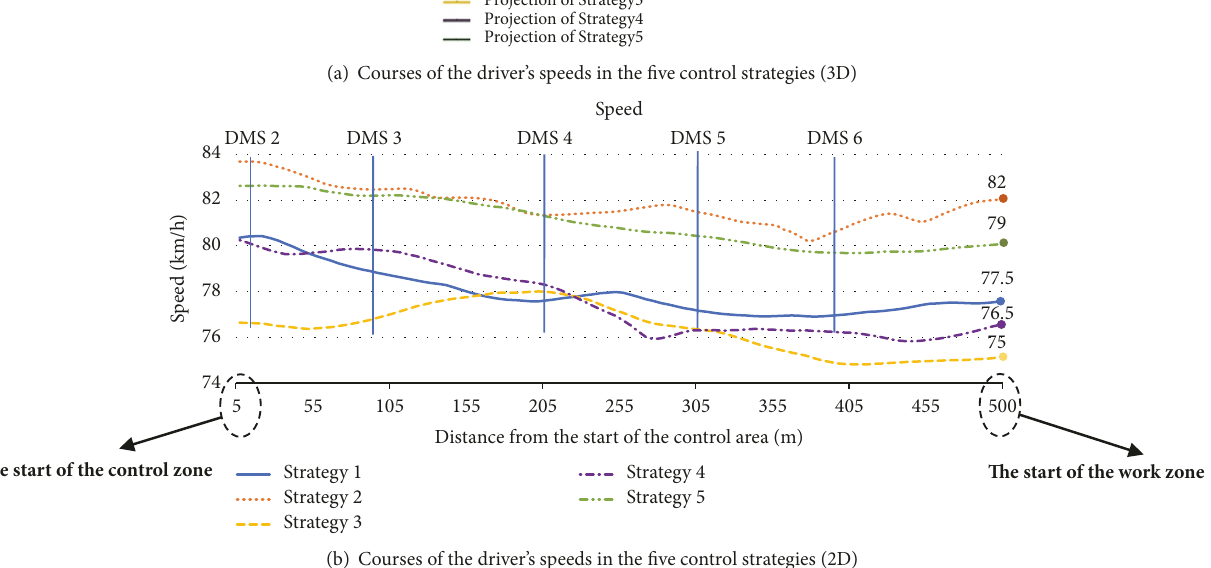
Figure 5: Courses of the driver’s speeds in the five control